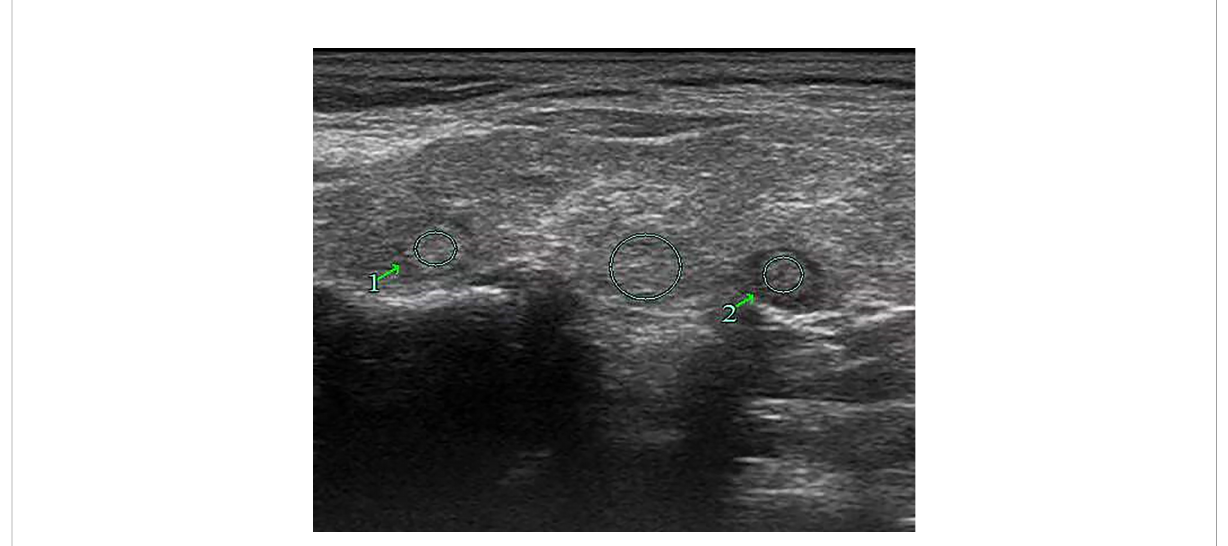
FIGURE 7 Female patient, 63 years old, 1-week case history of a right-side thyroid nodule, pathology con fi rmed as nodular goiter with HT. TPO-Ab > 1,300 kU/L, TG-Ab = 46.7 kU/L, UGSR 1 = 100.77/98.43 = 1.024, UGSR 2 = 84.82/98.43 = 0.8617 (medical center